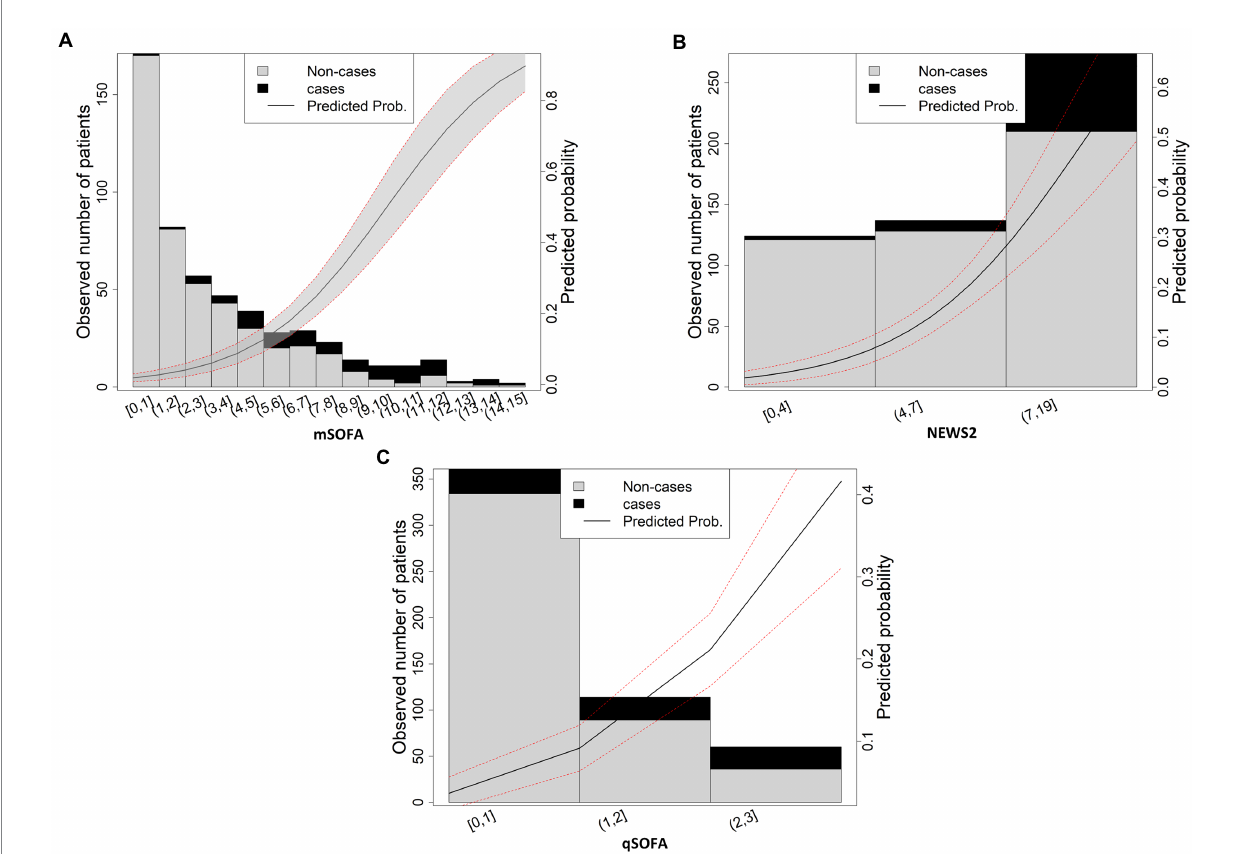
FIGURE 2 Scores values vs. real and predicted probability for mortality (A) mSOFA, (B) NEWS2, (C) qSOFA. The solid line shows the predicted probability of the outcome; area between dashed lines shows the 95% confidence